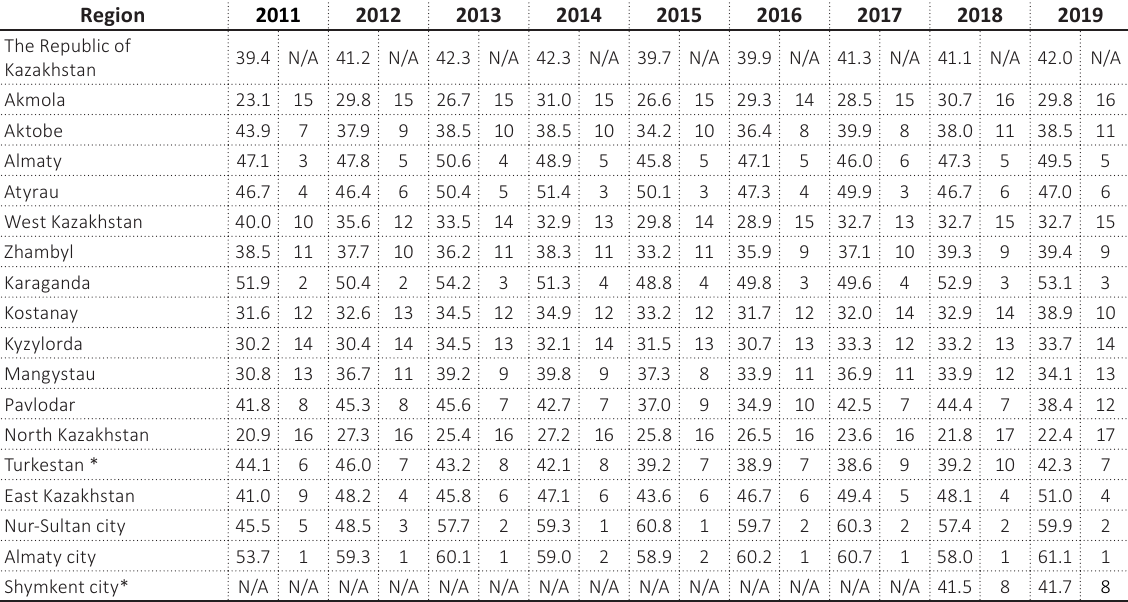
Table A1. Index and ranking of social and economic development of Kazakhstani regions, 2011–2019